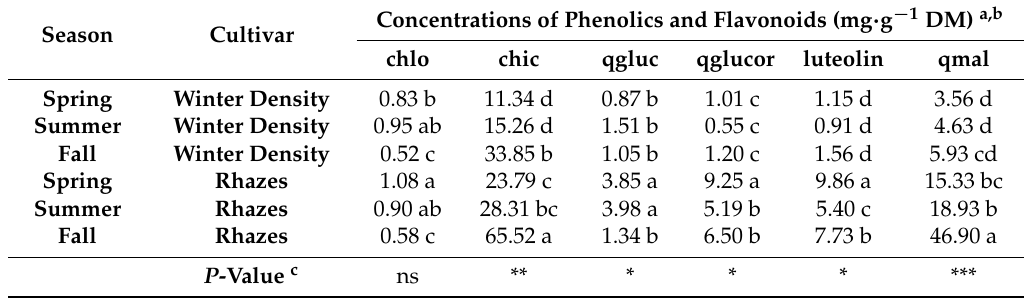
Table 3. The effect of seasons and cultivars on concentrations of greenhouse lettuce phenolics and